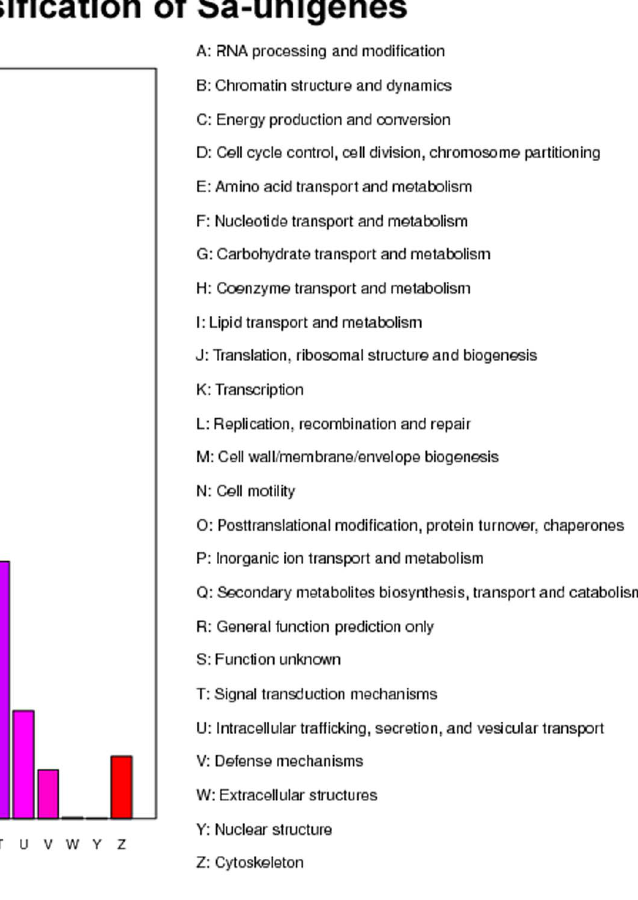
process (GO: 0009987) and metabolic process (GO: 0008152) were highly represented. For molecular functions, binding activity (GO: 0005488) was the most represented GO term, followed by the catalytic activity (GO: 0003824). The most represented category for cellular components was cells (GO: 0005623) (Figure 2).